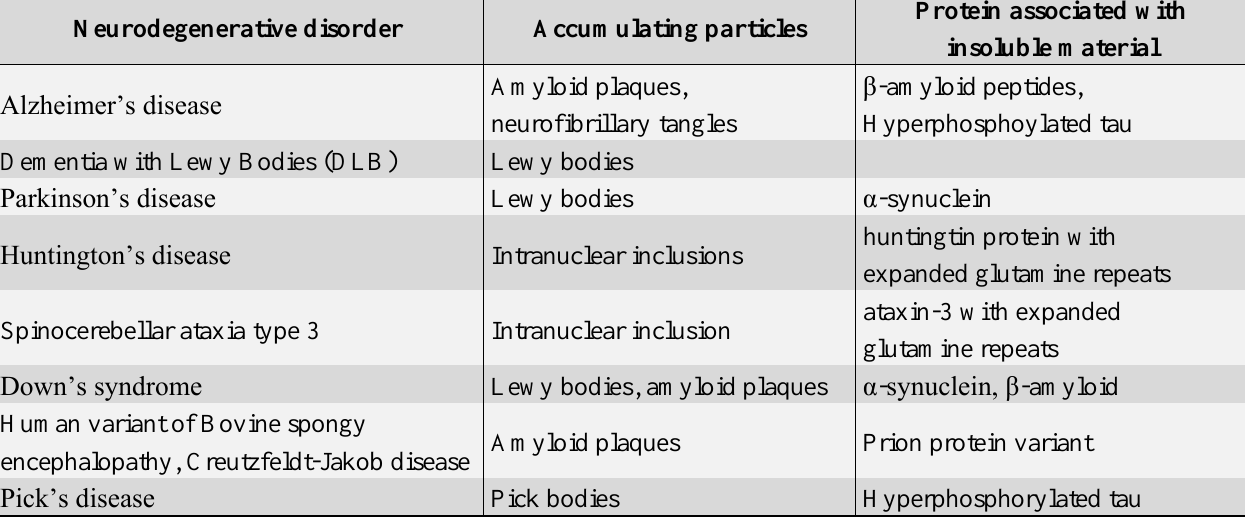
Table1. Proteinaceous inclusions associated with specific neurological